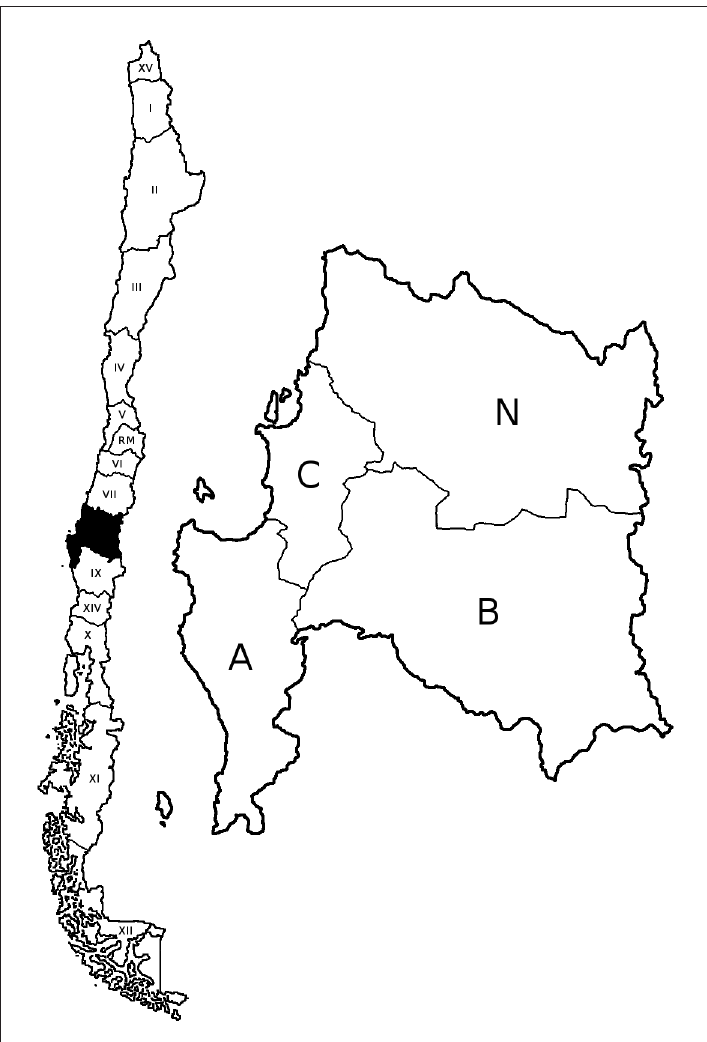
Figure 1. Left. Map of Chile showing in black the location of Bío-Bío Region (VIII) and the rest of Chilean Regions in Roman numerals (RM=Metropolitan Region). Right. Detail of Bío-Bío Region map showing the four provinces (A=Arauco, B=Bío-Bío, C=Concepción,